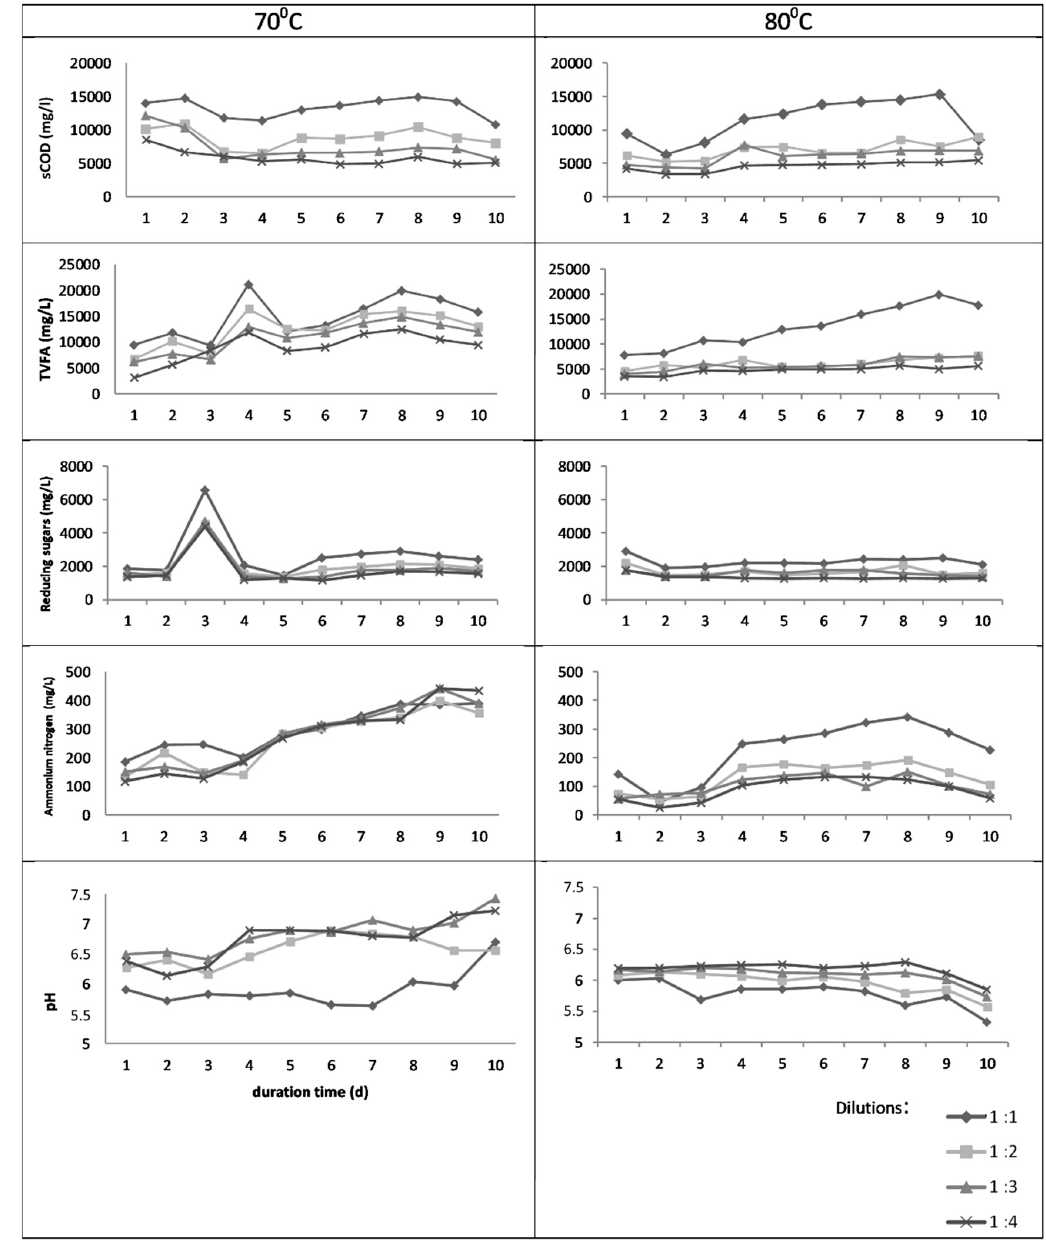
Figure 2. Evolution of sCOD, TVFA, reducing sugars, ammonium nitrogen and pH during hyperthermophilic treatment of grass.